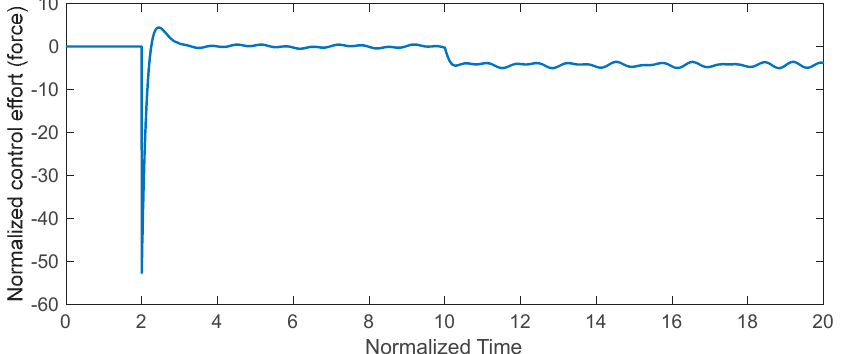
Figure 8. Control command based on the proposed control technique in the presence of disturbances and faults in the actuator.